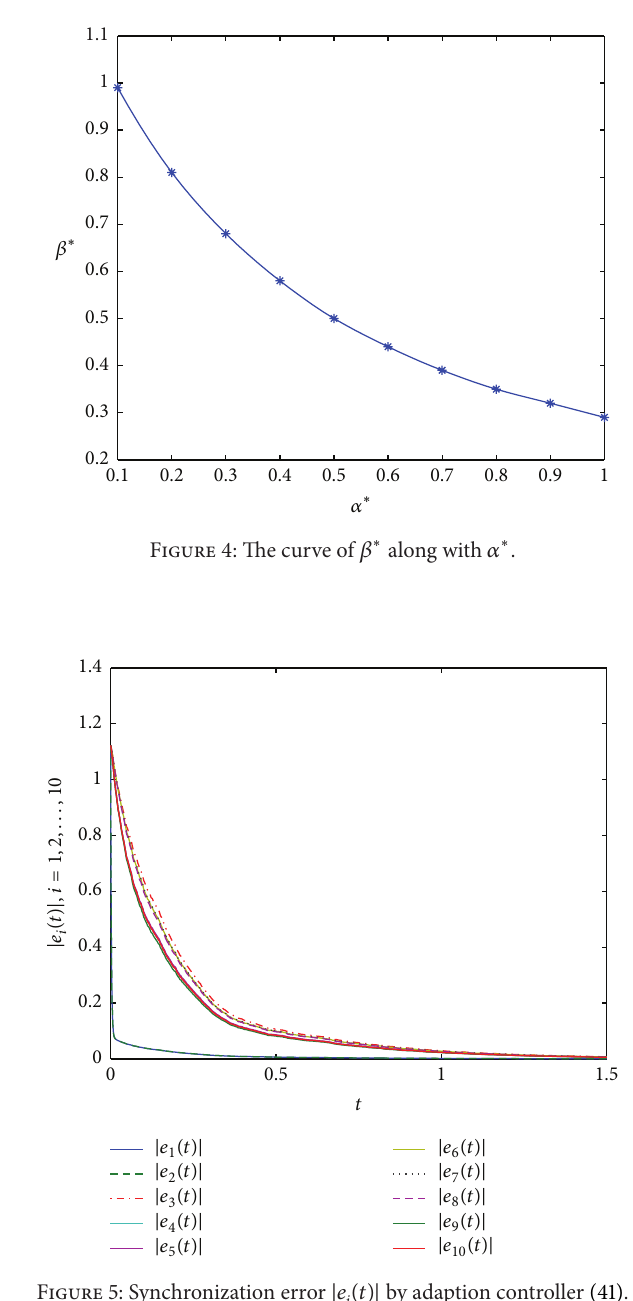
Figure 5: Synchronization error |𝑒 𝑖 (𝑡)| by adaption controller